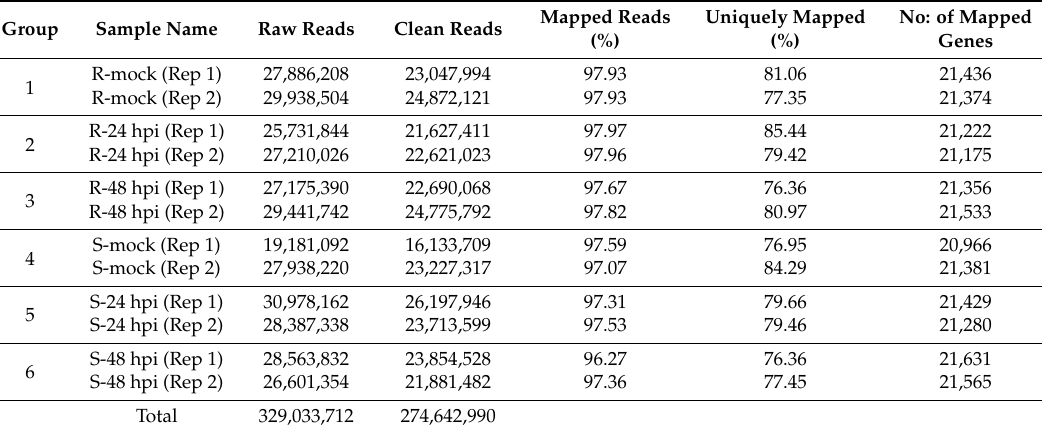
Table 1. Summary statistics of RNA-seq data and mapping